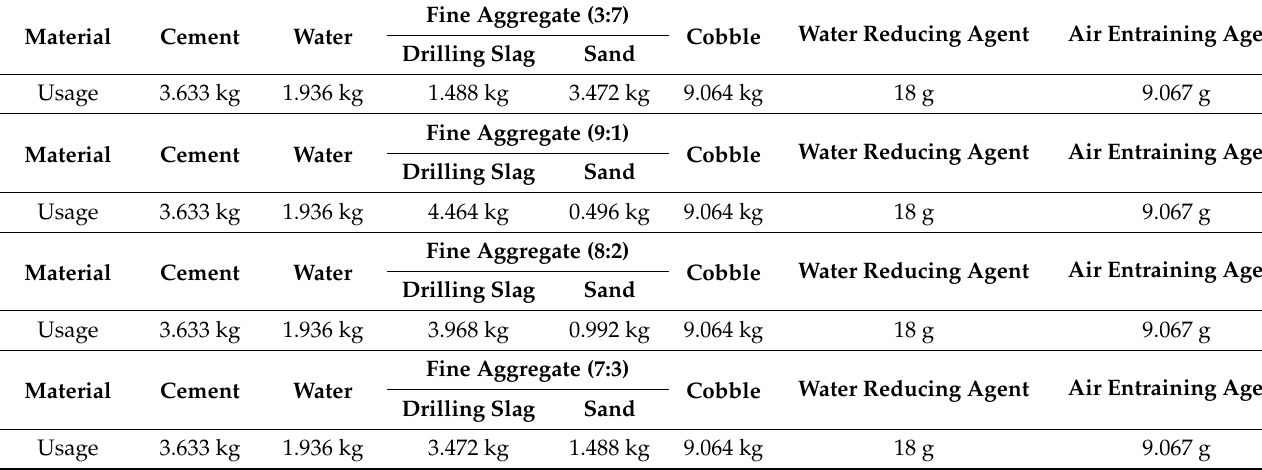
Table 3. Experiments with different